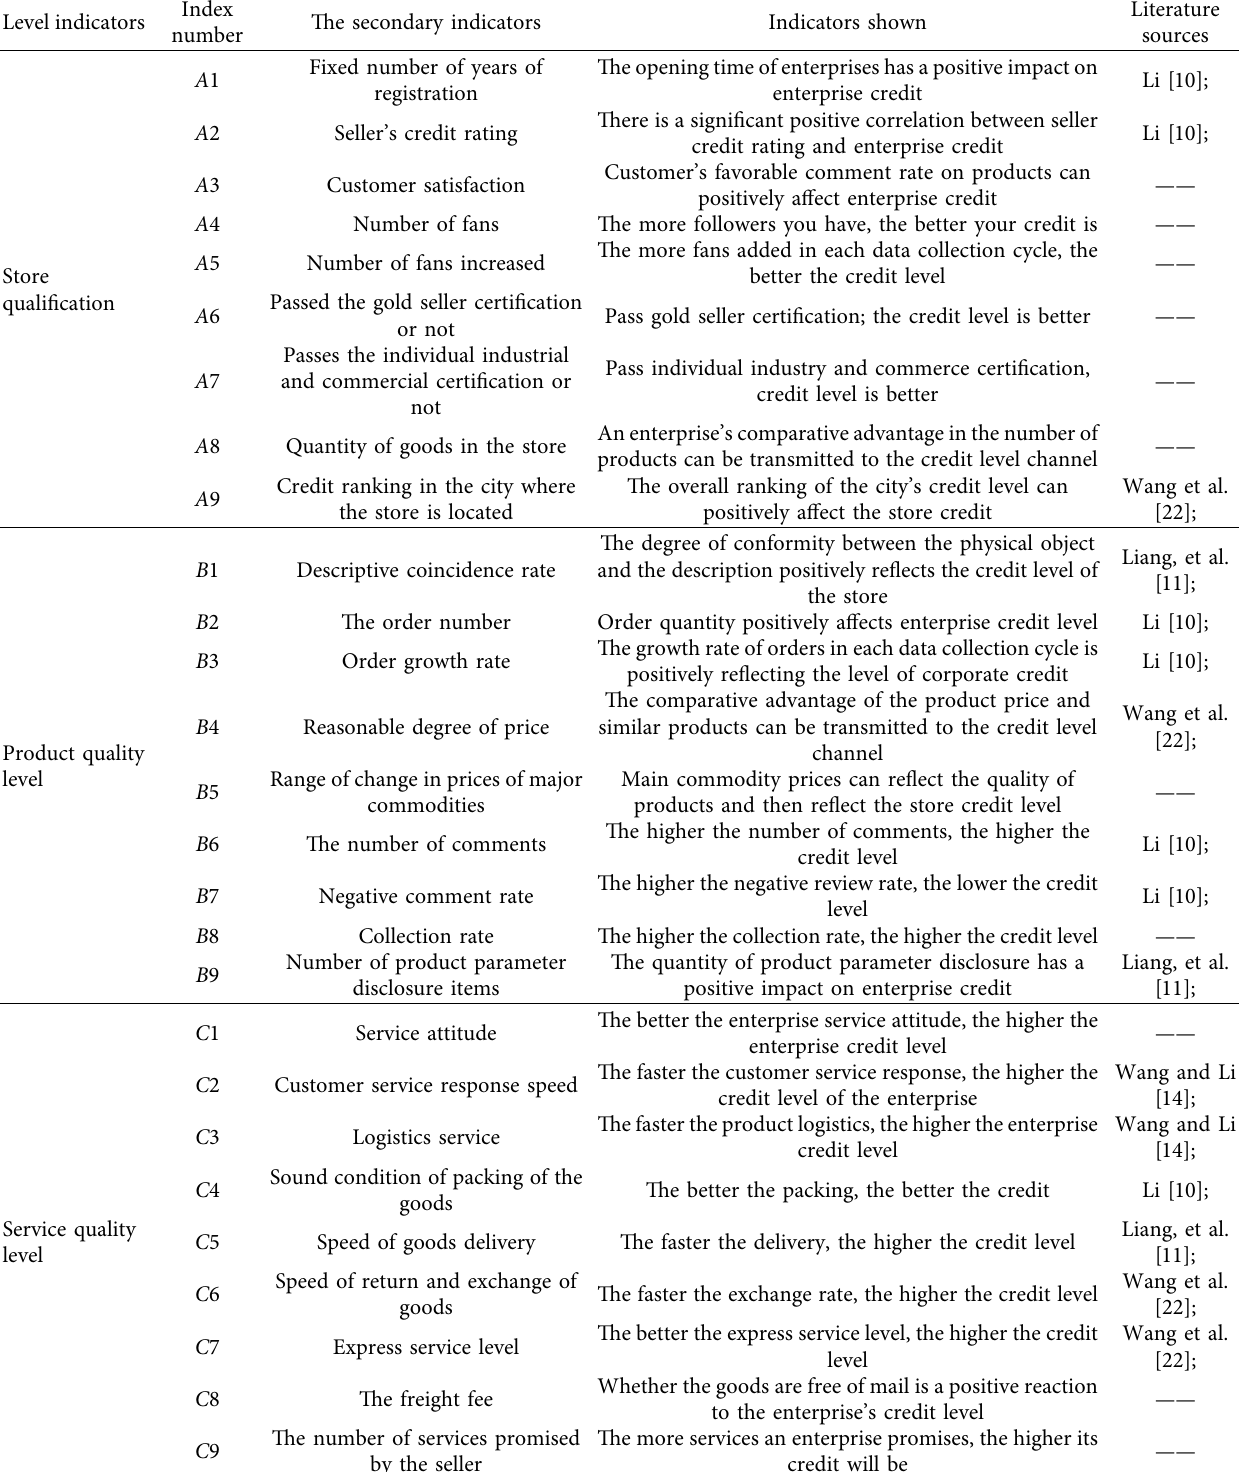
Table 1: The e-commerce SMEs credit risk evaluation index